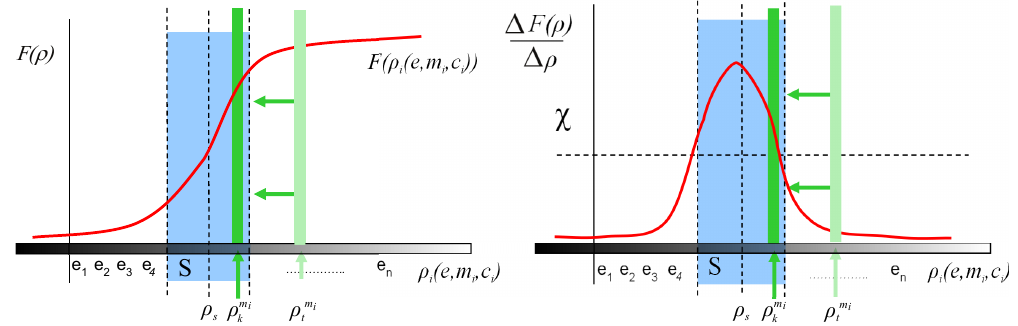
Figure 3. Outline for a System Calibration Υ S shifting the working point to S . The initial working point ρ m i ( light green ) has been moved to ρ m i t point ρ m i is close enough to the tuning point ρ s k